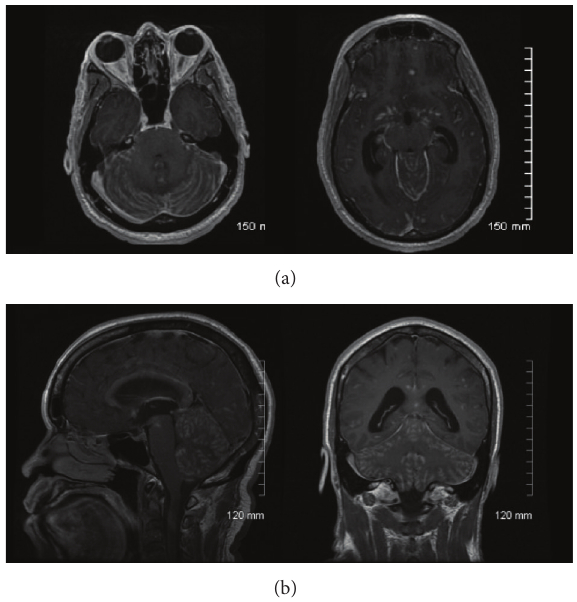
Figure 1: Initial MRI: T1 postcontrast axial images on the top row, sagittal and coronal on bottom row.